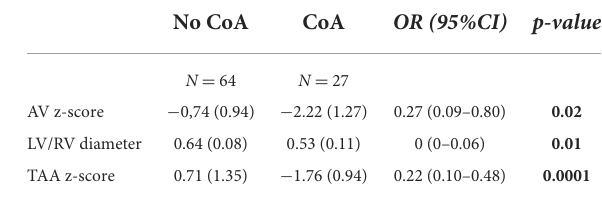
TABLE 3 Multivariate logistic regression analysis of potential risk factors for